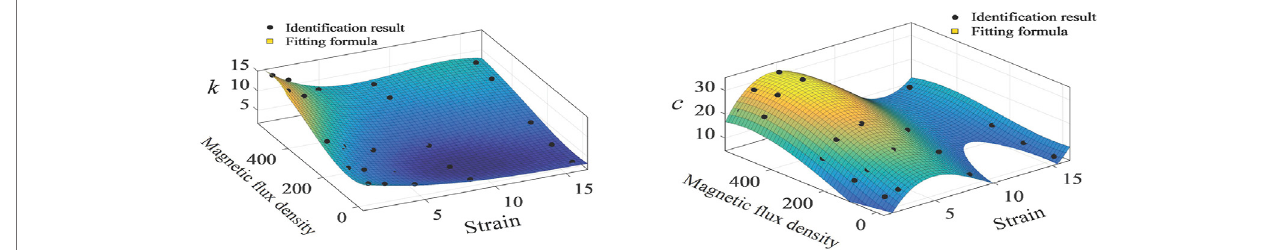
FIGURE 11 | Parameter fi tting curve of modi fi ed Bouc-Wen model.